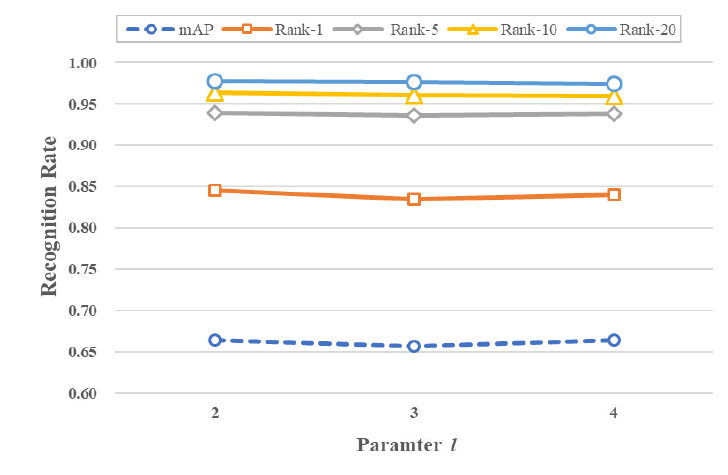
Figure 5. The influence of l on performance.